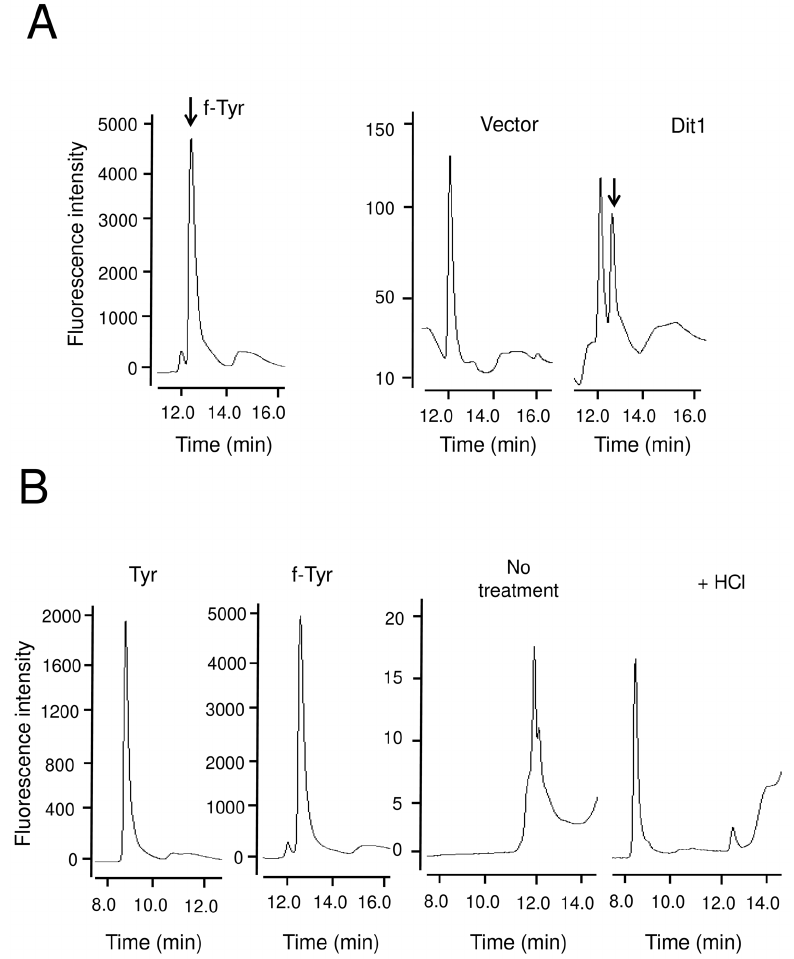
Figure 6. Trisodium citrate treatment of yeast lysates and formyl tyrosine detection. ( A ) The lysate of vegetative cells harboring pRS424GAL1-DIT1-GFP (Dit1) or pRS424GAL1 (Vector) were treated with trisodium citrate and subjected to HPLC analysis. Formyl tyrosine (f-Tyr) is shown as a control. Arrows indicate formyl tyrosine peaks. ( B ) The formyl tyrosine peak detected in the lysates of vegetative cells harboring pRS424GAL1-DIT1-GFP was collected, hydrolyzed with 6 N HCl and subjected to HPLC analysis. Tyrosine (Tyr) and formyl tyrosine (f-Tyr) are shown as